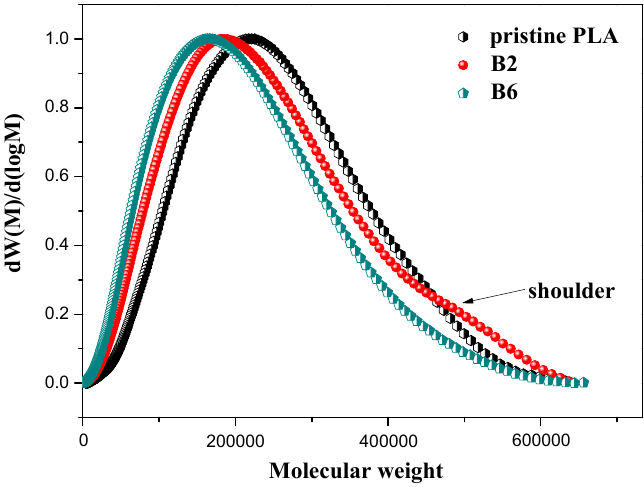
Figure 7. Molecular weight distributions of pristine PLA and modified samples. Table 2. Molecular weight and its distribution of samples.